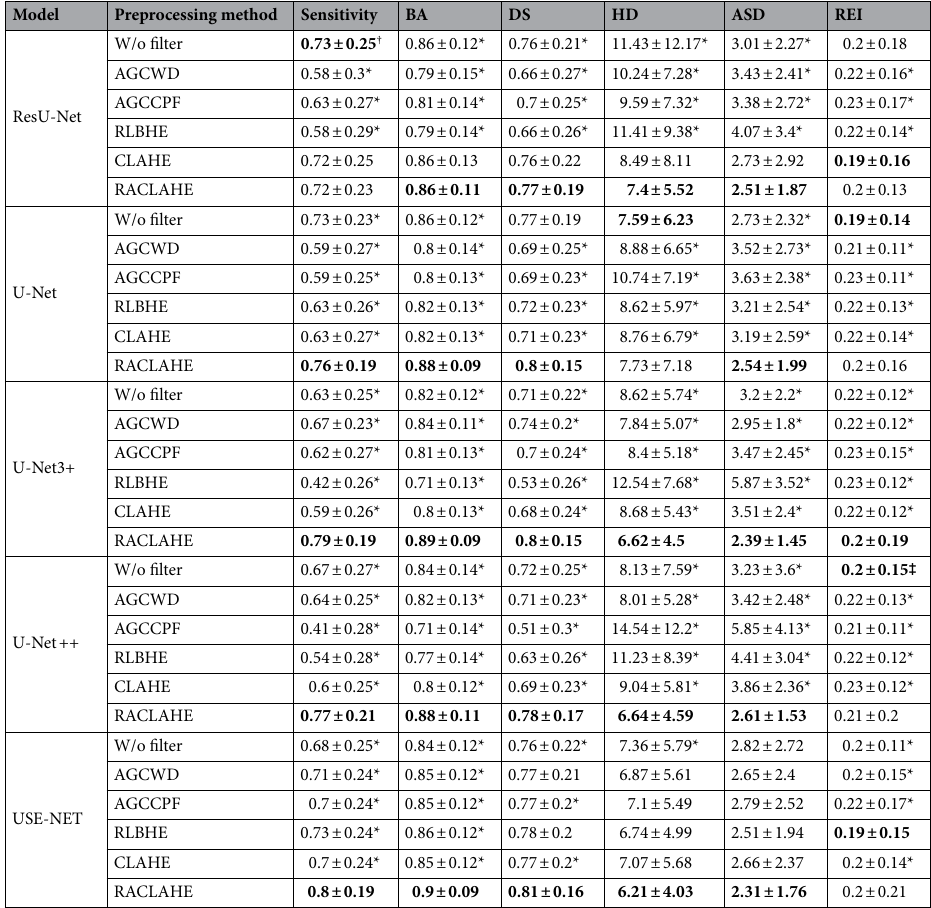
Table 3. Transitional zone (TZ) segmentation performance. BA balanced accuracy, DS dice score, HD Hausdorff distance, ASD average surface distance, REI Rand error index, AGCWD adaptive gamma correction with weighting distribution, AGCCPF adaptive gamma correction with color preserving framework, RLBHE range limited Bi-histogram equalization, CLAHE contrast limited adaptive histogram equalization, RACLAHE region adaptive contrast limited adaptive histogram equalization. *RACLAHE performs significantly better than the corresponding method (p-value ≤ 0.05; Wilcoxon rank-sum test). † This method is significantly better than RACLAHE (p-value ≤ 0.05; Wilcoxon rank-sum test). The best performance scores for each model are shown in